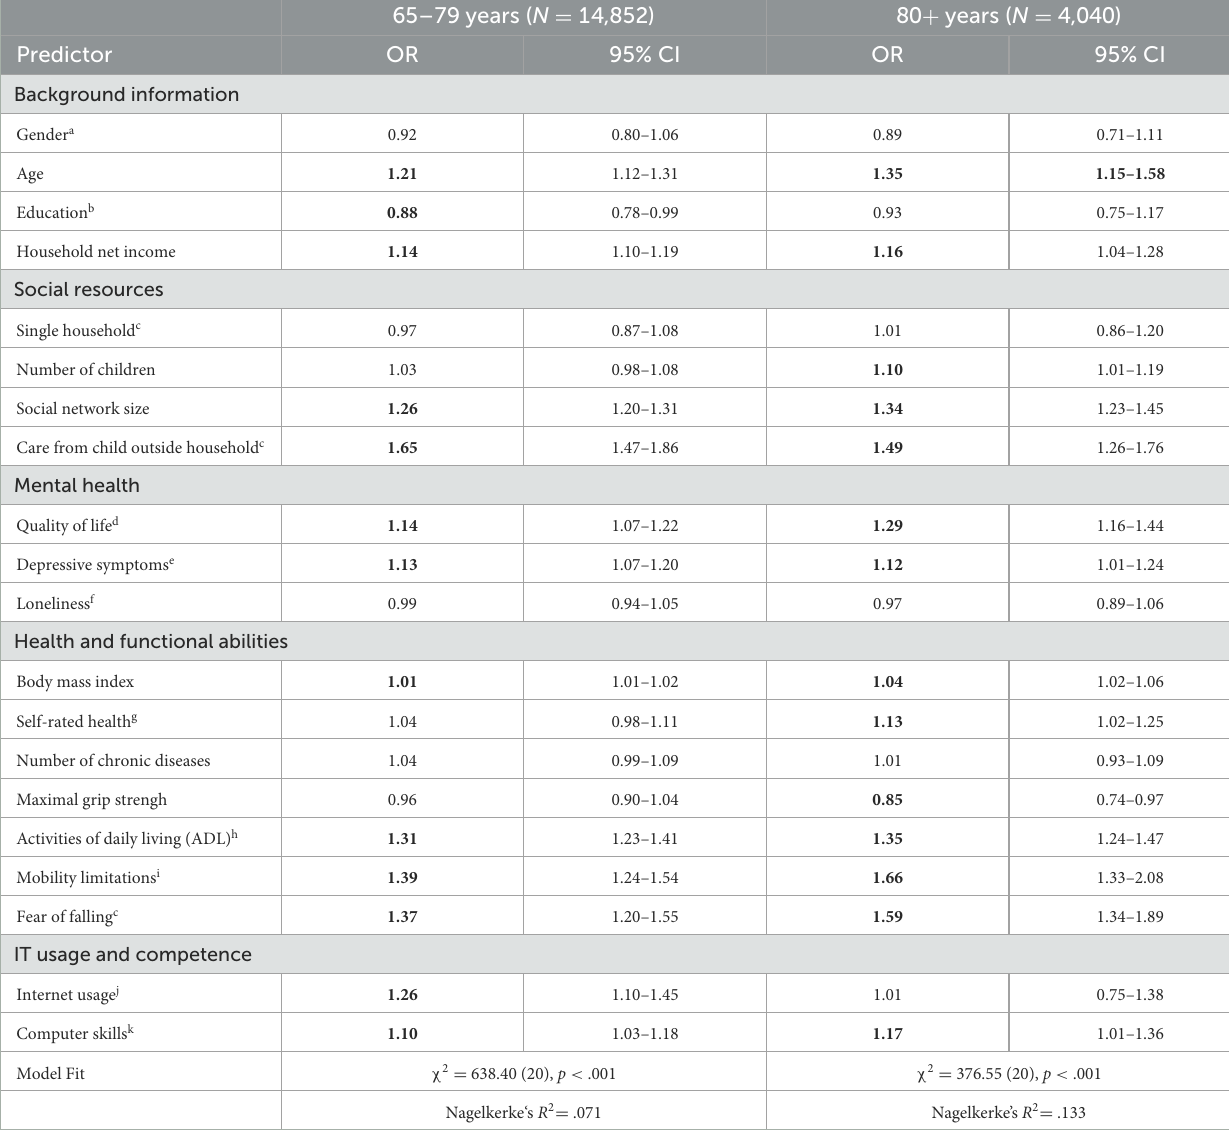
TABLE 3 Logistic regression analyses explaining the implementation of technology-based home modifications by age